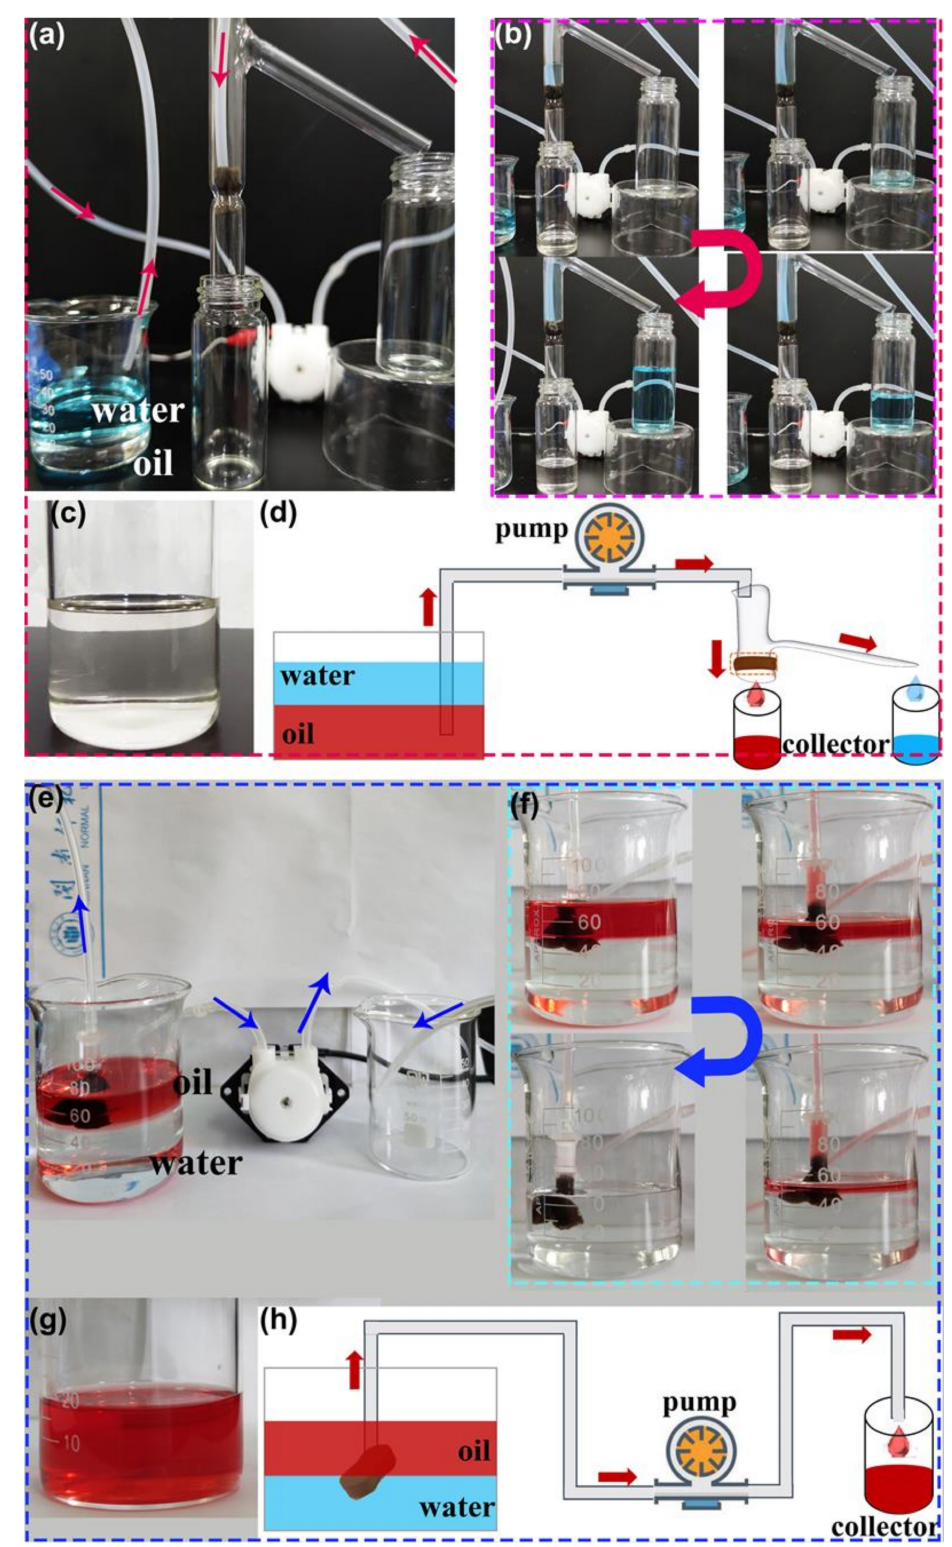
Figure 8. Photographs of ( a , e ) the continuous oil/water separation system, ( b , f ) the progress of the continuous removal of oils (carbon tetrachloride and n-hexane, respectively) from the water. ( c , g ) Photographs of the collected oils. ( d , h ) Schematic summary of continuous separation for oil − water